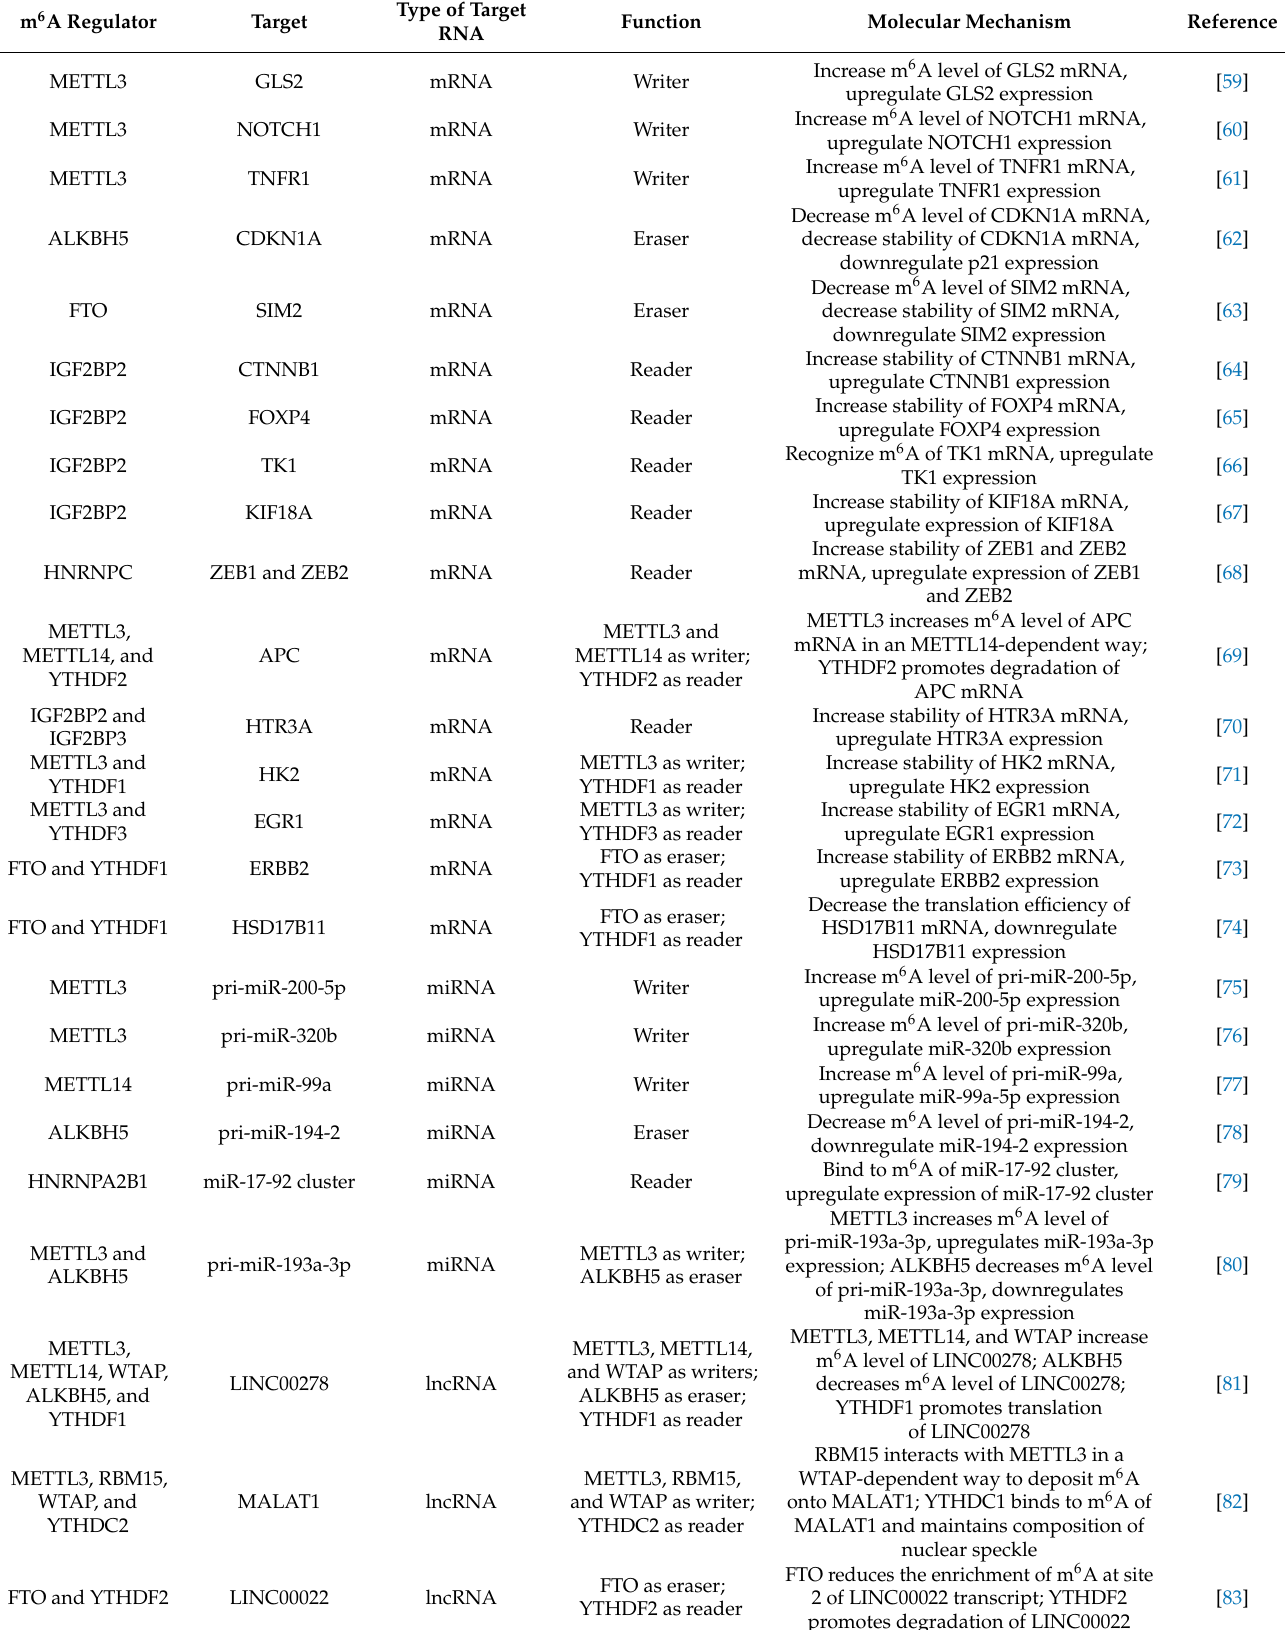
Table 1. The m 6 A methylation modified various RNAs in